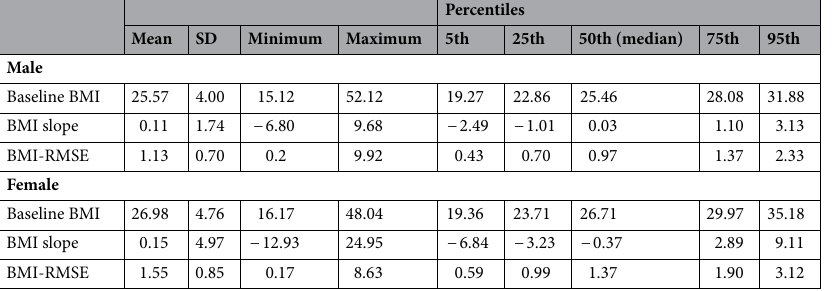
Table 2. The mean, SD and percentile values of BMI variation (RMSE), slope and baseline